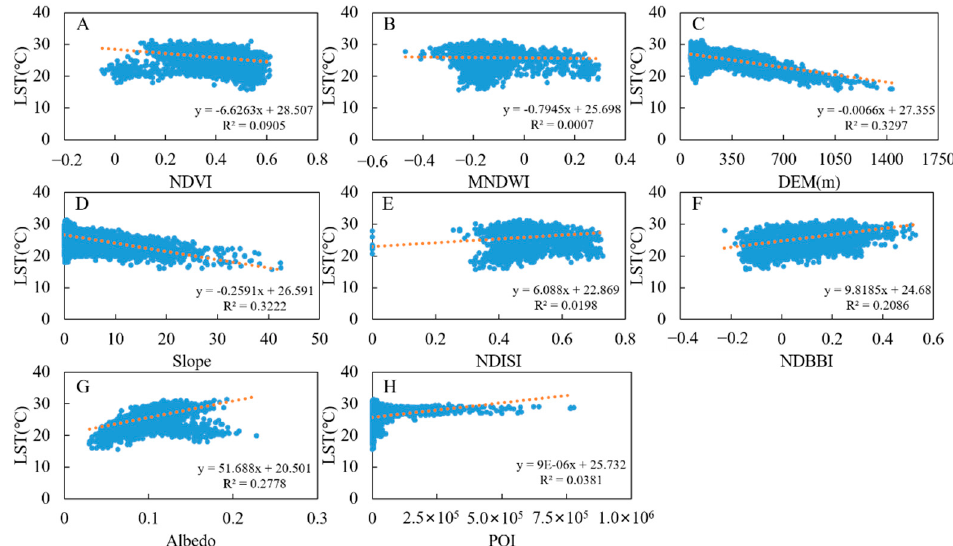
Figure 5. Linear relationship between influencing factors and LST in Zhengzhou: ( A ) NDVI; ( B ) MNDWI; ( C ) DEM; ( D ) Slope; ( E ) NDISI; ( F ) NDBBI; ( G ) Albedo; ( H ) POI.